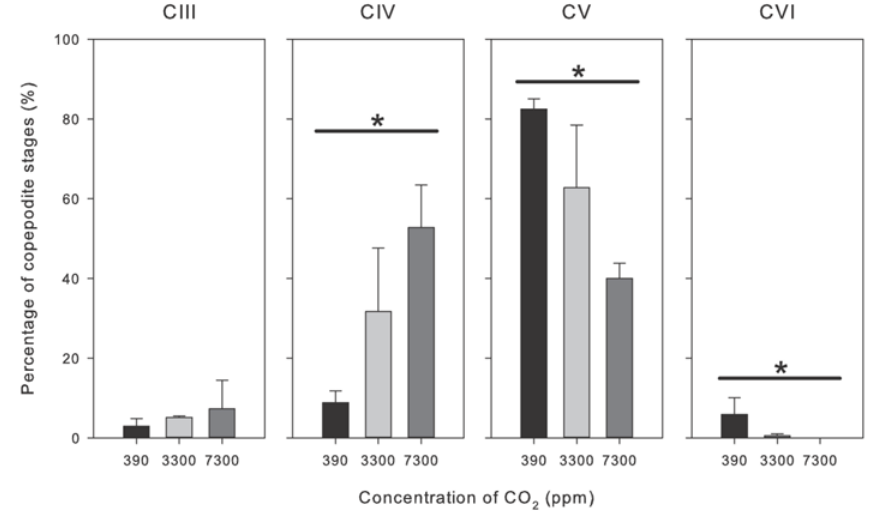
Fig. 3. Stage distribution (percentage) of the copepodites exposed to different levels of CO 2 -acidified seawater. Three replicate groups at each exposure level. The bars show mean ± 1 std. Significant differences ( p < 0 . 05) between the experimental groups are indicated by asterisks